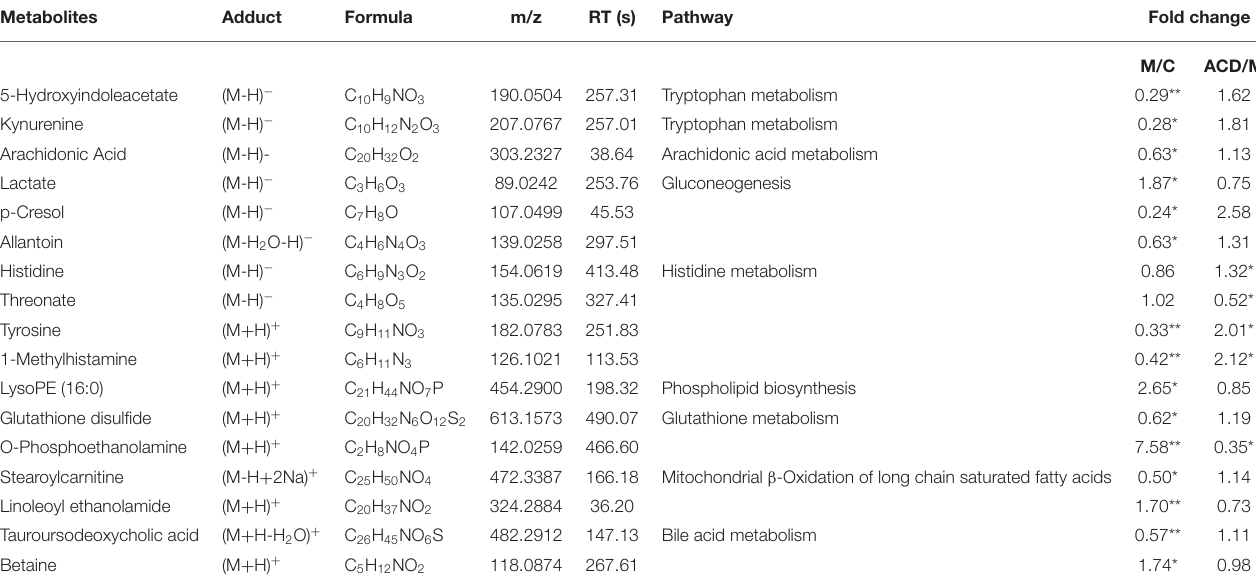
TABLE 2 | Potential biomarkers related to ACD treatment identified in the liver from laying hens with FLHS ( n = 8). Metabolites